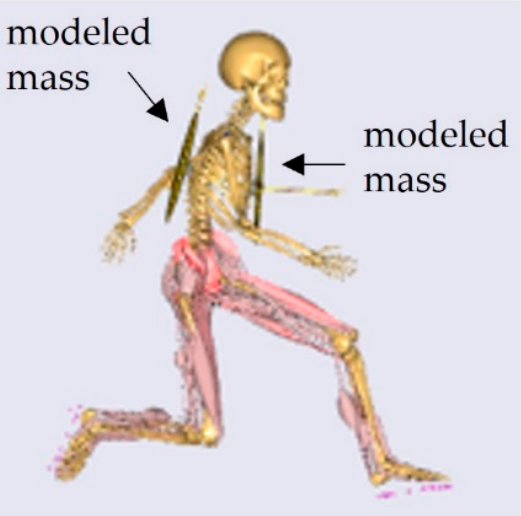
Figure 3. Modeled external load attached to chest and back in the AnyBody modeling system.